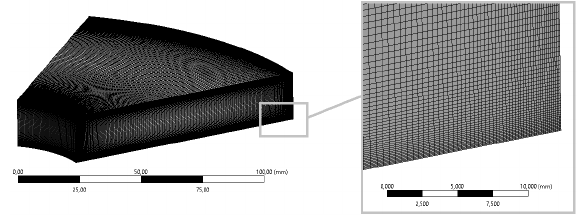
Fig. 2. Mesh of the